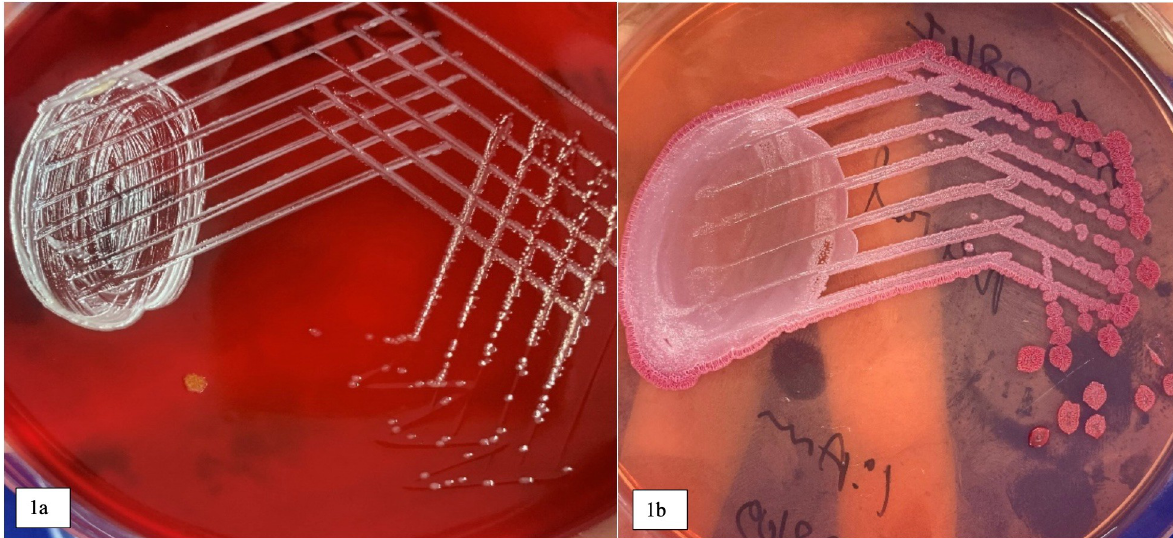
Fig 1. (a) Approximately 1–2 mm in size, white colored, round, smooth, elevated colonies with metallic sheen after 24 hours incubation on Sheep Blood agar. (b) Non-lactose fermenting, 2–4 mm in size, dry wrinkled colonies on MacConkey agar after 48–72 hours of